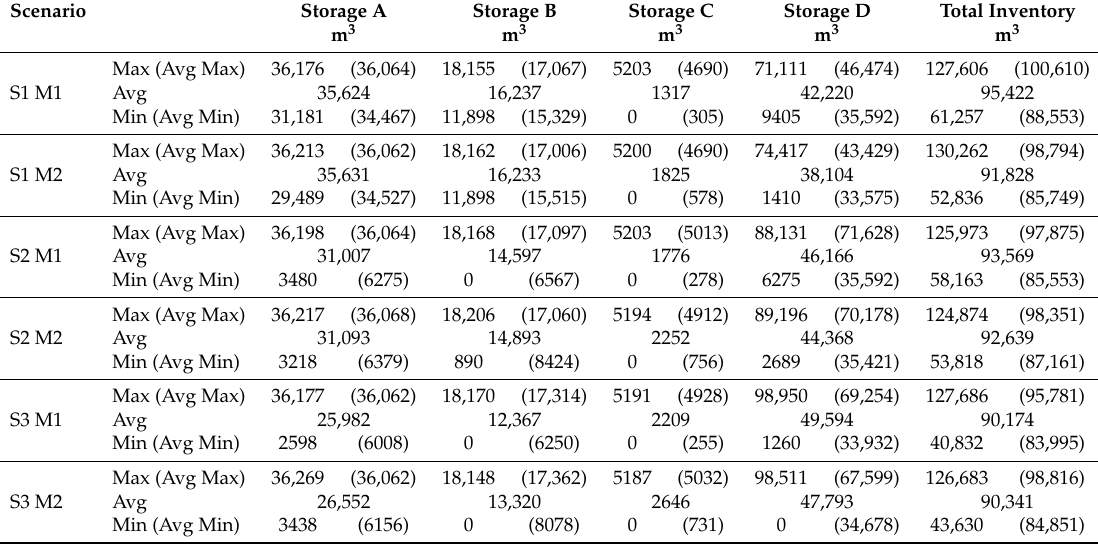
Table 3. Pulpwood inventory levels at the four storage areas and the total log-yard inventory level over the 52-week period under six scenarios based on 30 simulation results per scenario. The scenarios are given labels of the form Sx My where x is the number of the inventory strategy and y is the number of the machine system used to transport logs between storage areas D and C. The max and min values are the maximum and minimum volumes observed at the indicated storage area in any one of the 30 simulation runs for the indicated scenario. The Avg Max and Avg Min values (shown in parentheses) are the maximum and minimum values observed in the average of the 30 simulation runs for the indicated scenarios, and are plotted in black in Figures